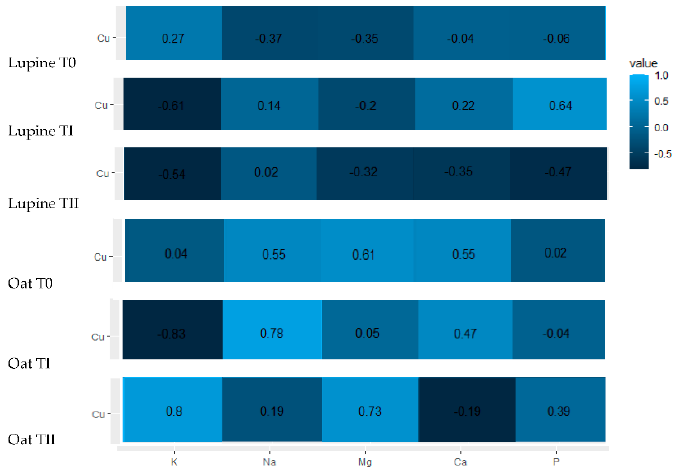
Figure 4. Heatmaps and correlations coefficients for between Cu content in the soils (T0–TII) and nutrients in plants: lupine and oat.